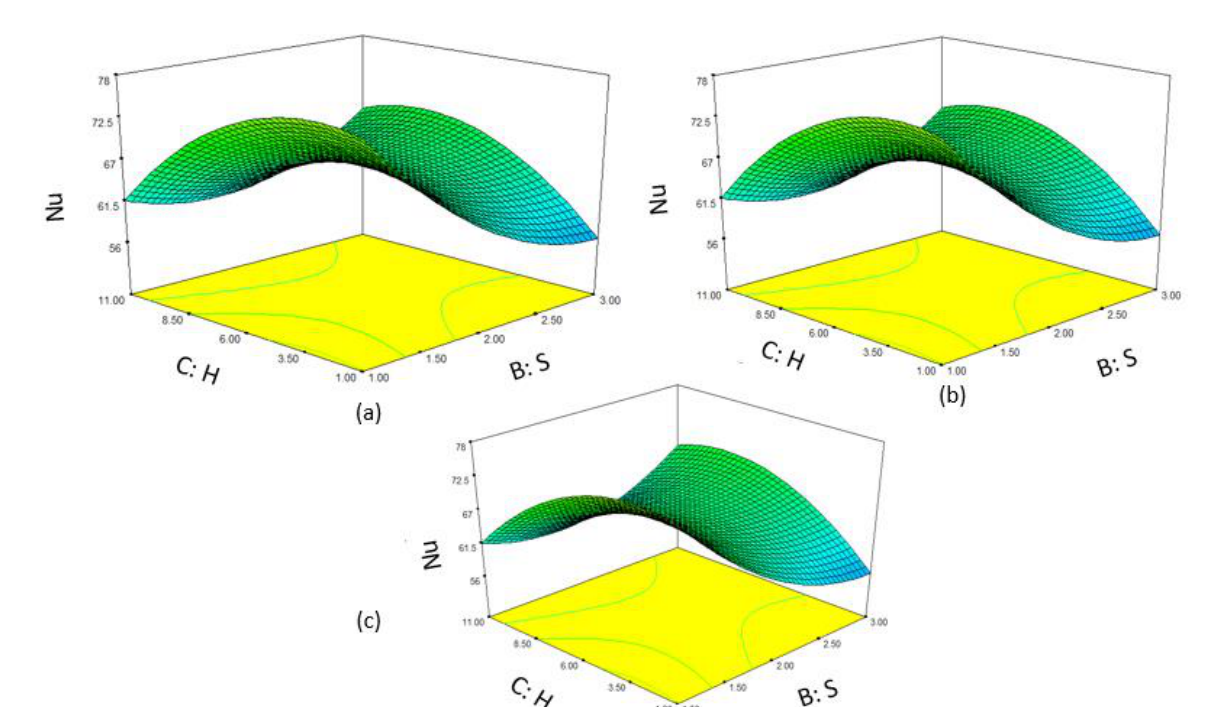
Figure 11. Nusselt contours and 3D surface formed by the impact of the nozzle-nozzle spacing and nozzle-plate distance at the optimum conditions for the optimization target of maximum Nusselt number and nanoconcentration equal to ( a ) 0.1%; ( b ) 0.5%; ( c ) 1%. Energies 2021 , 14 , x FOR PEER REVIEW